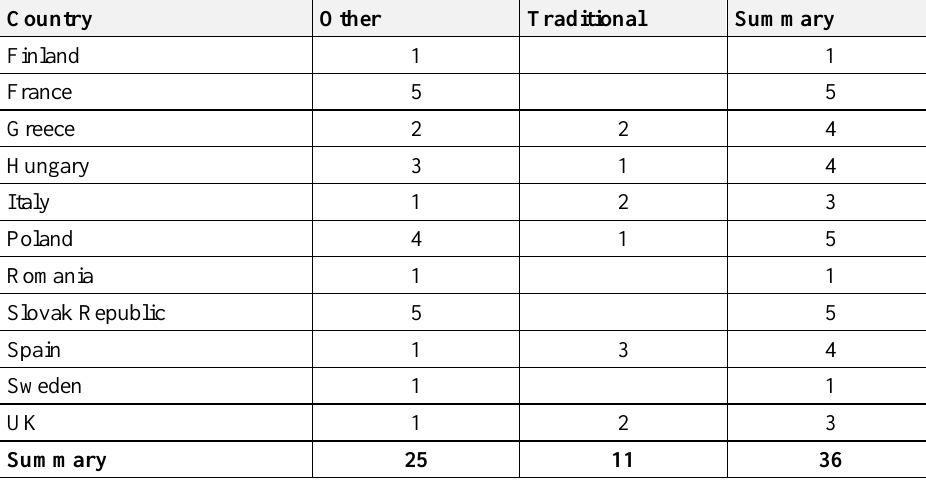
Table 2 – Sample distribution on Traditional and Other digital public spaces Country Other Traditional